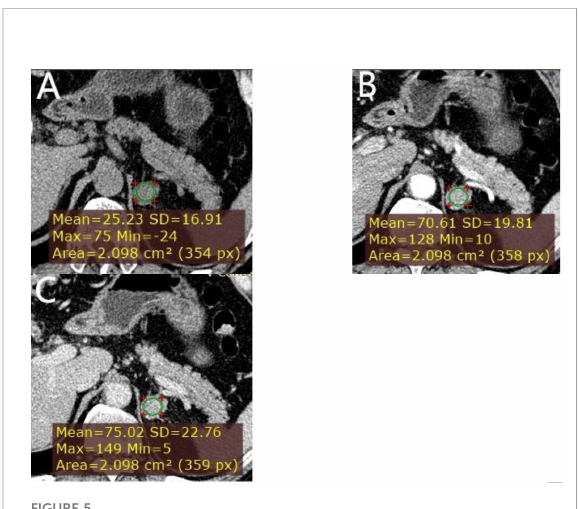
FIGURE 5 A left adrenal LPA in a 63-year-old man. (A) Axial unenhanced phase. (B) Axial arterial phase. (C) Axial venous phase. The values of CTu, CTa, CTv, and DEpeak were 25.23, 70.61, 75.02, and 49.79 HU, respectively. LD and SD of the mass were 25 and 20 mm. No cystic degeneration was seen within the